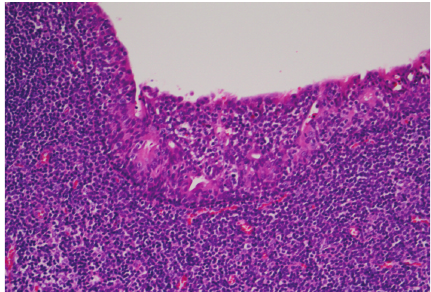
Figure 4: Low Power Field. Squamous mucosa with infiltrating lymphocytes.